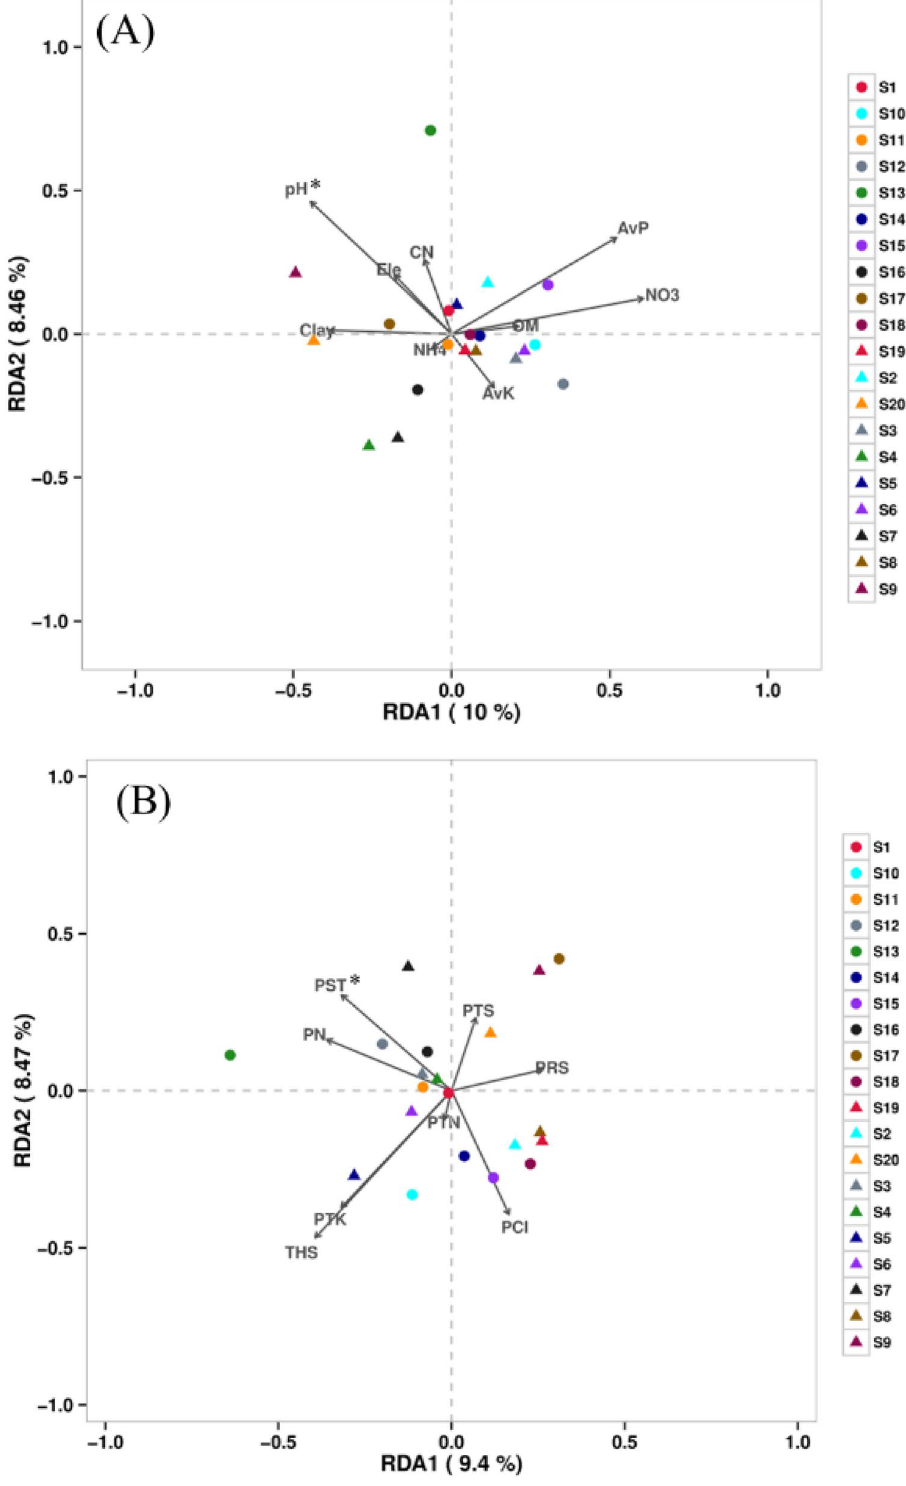
Figure 4. Redundancy analysis (RDA) of soil fungal communities with selected environmental factors ( A ) and chemical components of flue-cured tobacco leaves ( B ). The environmental variables include Ele the elevation of the sampling site, pH soil pH, CN soil C:N ratio, Clay soil clay content, OM soil organic matter content, NH4 soil ammonia content, NO3 soil nitrate content, AvK available potassium content, AvP soil available phosphorus content. Tobacco quality variables includes PN tobacco nicotine, PTN tobacco nitrogen, PRS tobacco reducing sugar, PTS tobacco total sugar, PST tobacco starch, PTK tobacco potassium, PCl tobacco chloride, THS total harmony scores of flue-cured tobacco